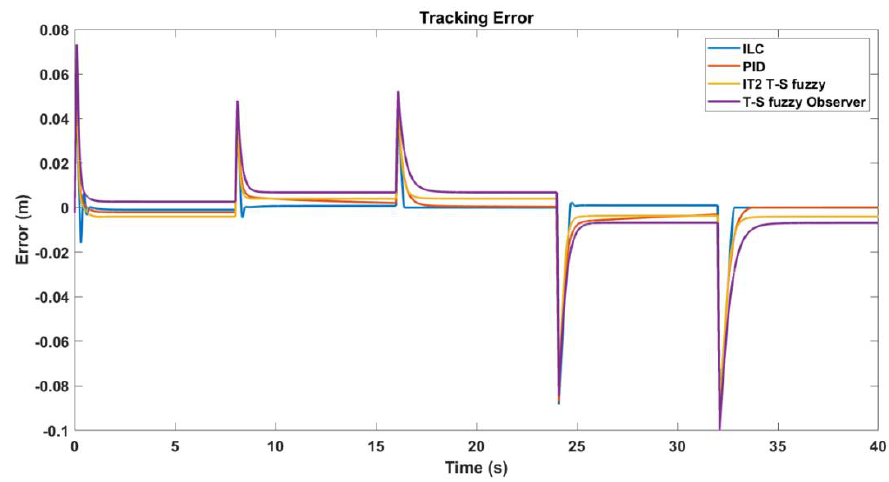
Figure 14. The comparison of controllers’ performance with respect to the tracking error.